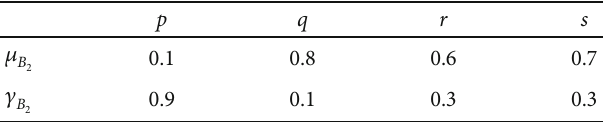
Table 38: Intuitionistic fuzzy set B